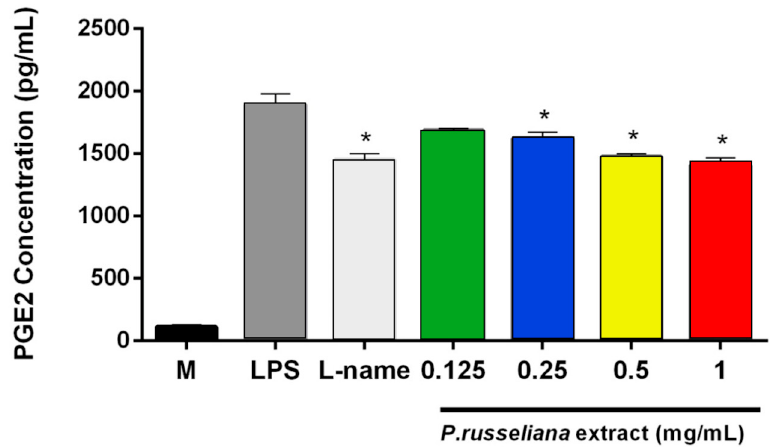
Figure 3. Analgesic effect of P. russeliana extract on LPS-induced production of PGE 2 . LPS: Control group treated with 1 µg/mL LPS. L-name: N - ( γ )-nitro- L -arginine methyl ester. Statistical significances were indicated for each compound vs. LPS (* p < 0.05).